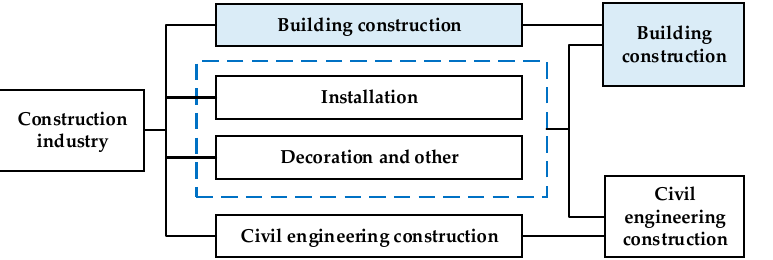
Figure 9. The disaggregation and aggregation of subsectors in the construction industry.